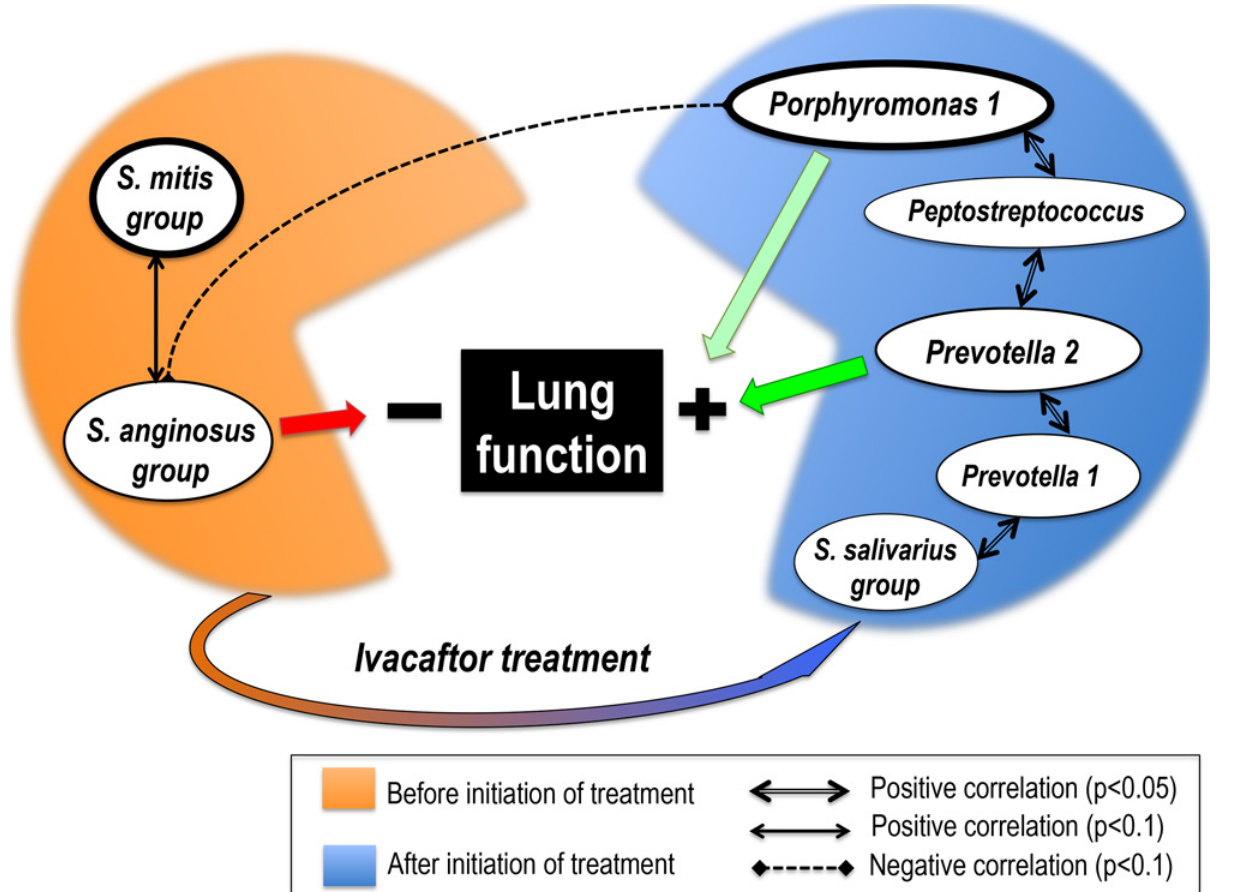
Fig 5. Dynamics and interrelations of 7 key-role OTUs throughout ivacaftor treatment, and their correlations with lung function. Streptococcus 1 ( S . mitis group) and Porphyromonas 1 were the two OTUs for which a significant association with ivacaftor treatment period emerged (Colin-White test; See S2 Table): Streptococcus 1 ( S . mitis group) was associated with sputum samples collected before (p < 0.05) and Porphyromonas 1 with samples collected after initiation of treatment (p < 0.01). The depicted correlations between OTUs were all statistically significant with the adjusted p-values (Spearman correlation test; see Table 3). Significant correlations between OTUs and lung function (on FEV-1 test) are shown by red arrow when negative (p < 0.05) and green arrow (light green if p < 0.1; dark green if p < 0.05) when positive (adjusted p-values; see Table